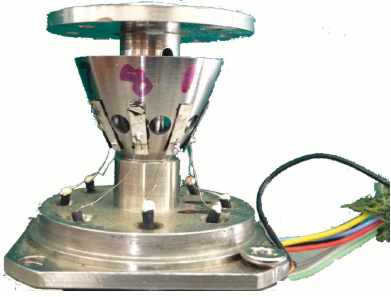
Figure 16. Prototypal bell-shaped